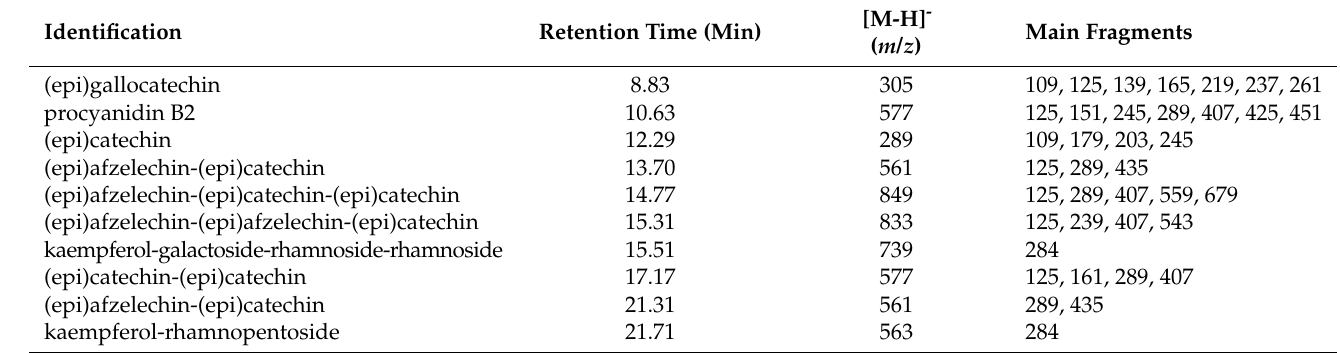
Table 2. Compound identification of EAF2 (ethanol: water 50:50 v / v ) detected by UHPLC-HRMS negative